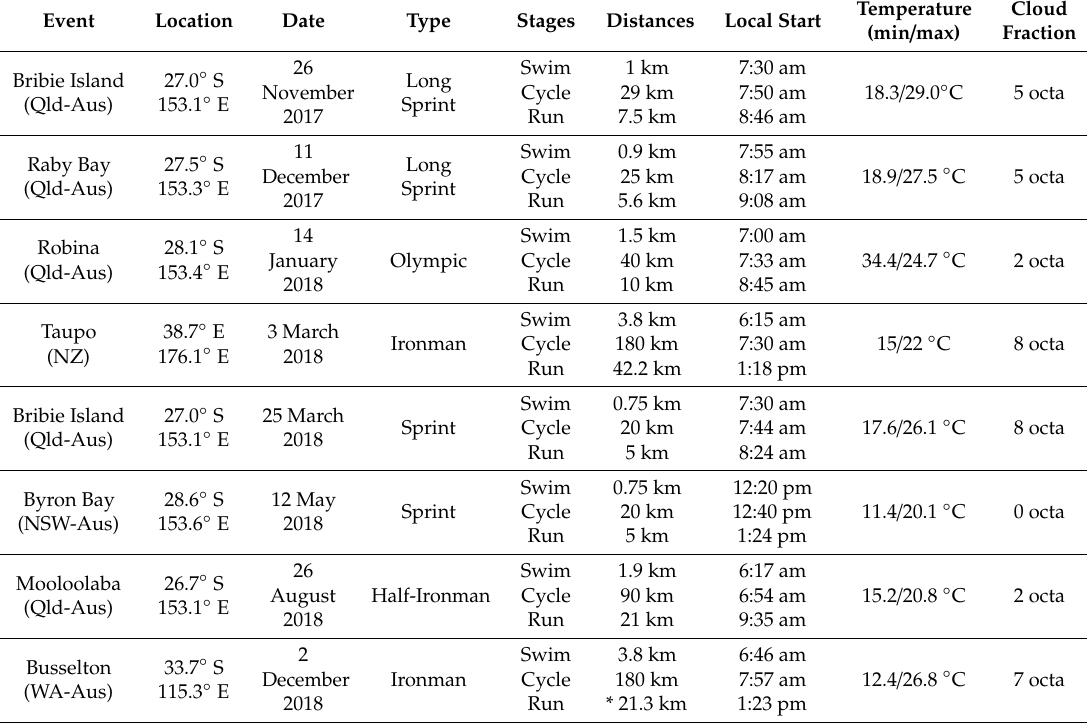
Table 2. Scheduled participant triathlon events listed by event category in the period 2017 to 2018.